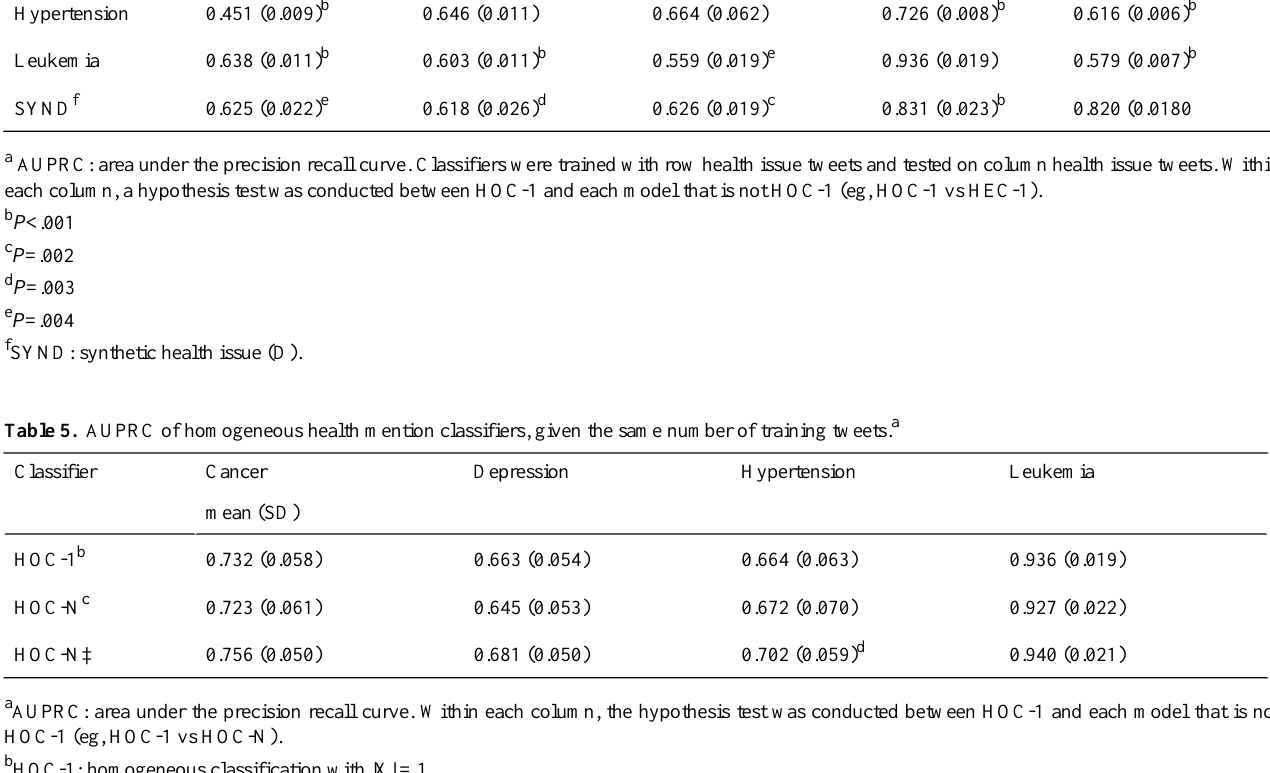
SYNDLeukemiaHypertensionDepressionCancer